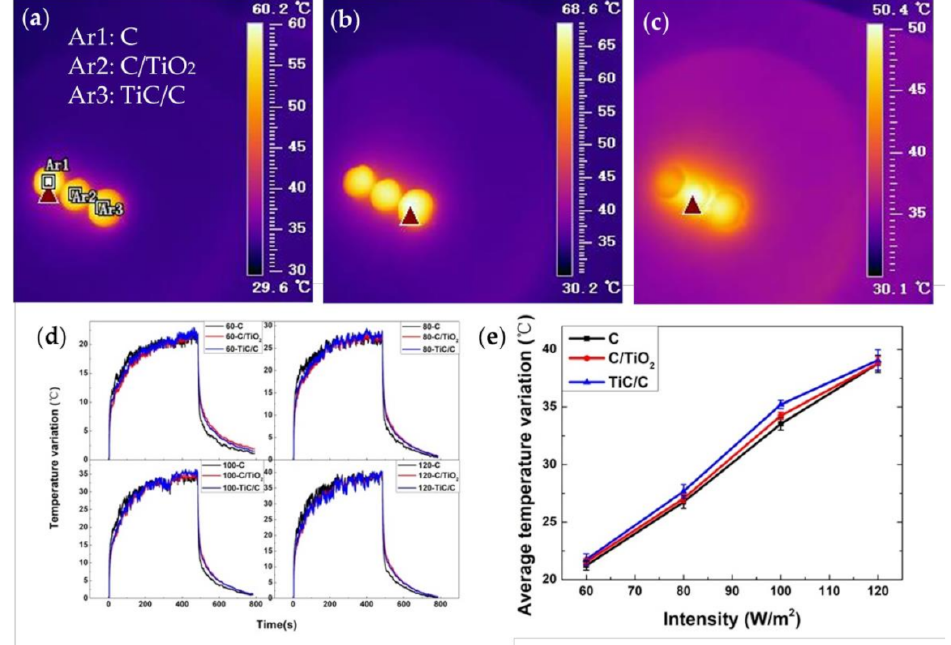
Figure 9. Thermal camera image of three samples after illuminating for 90 s: ( a , b ) in the equilibrium state; ( c ) within 6 s after turning o ff the illumination; ( d ) temperature variation curves of C, C / TiO 2 and TiC / C aerogels at four di ff erent light intensities; ( e ) average temperature variation within 54 s before the ending of illumination at di ff erent intensities of three